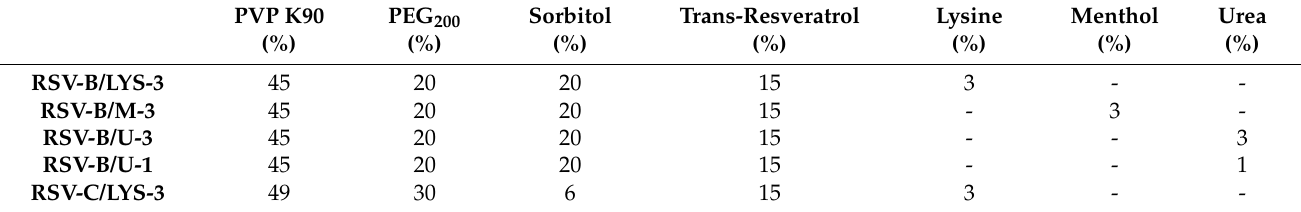
Table 2. Composition (as w / w percent) of RSV-loaded pharmaceutical powders that include the selected CPEs. PVP